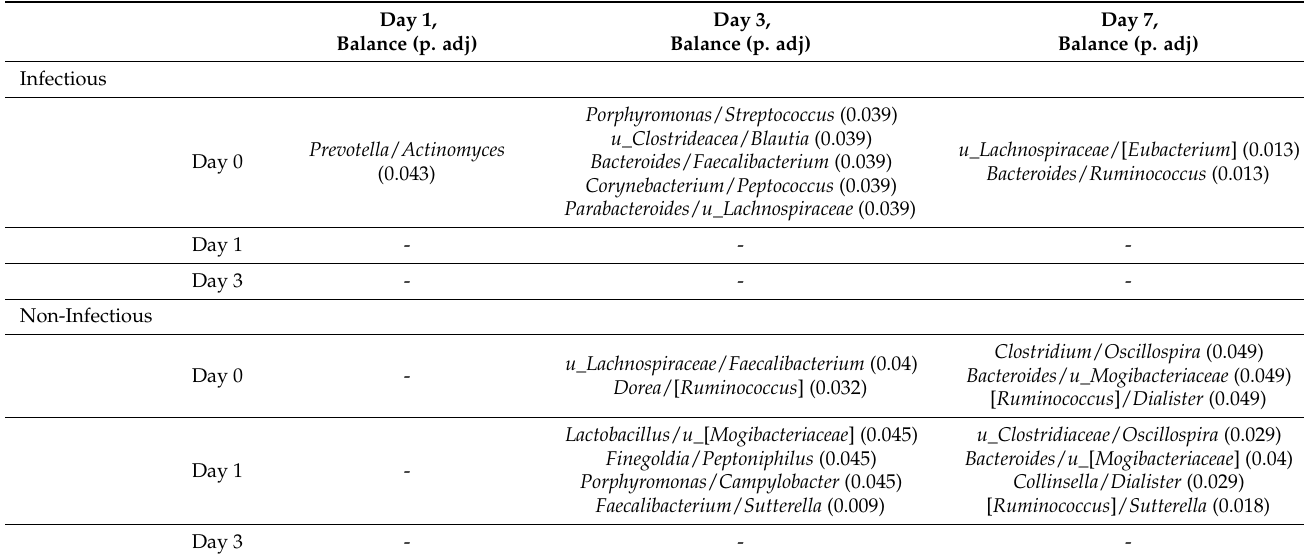
Table 2. Significant changes in individual taxa proportions after the surgery. The preliminary balances list was obtained by the discriminative balance analysis (DBA). The statistical significance of each balance change was tested by a linear mixed effect model with subject identifier as a random effect. Benjamini-Hochberg method was used to adjust for multiple testing.